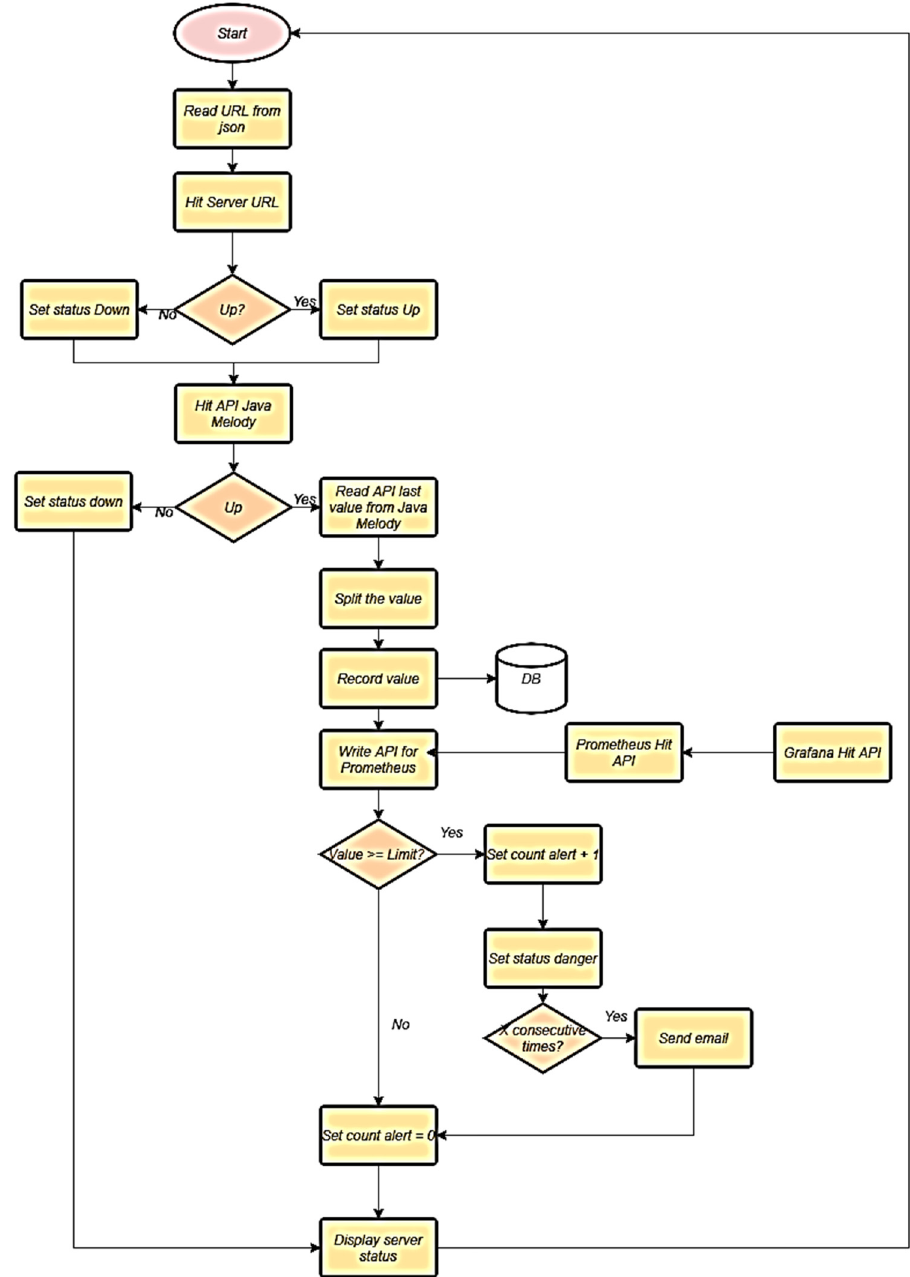
Figure 2: Flowchart web application Java application server